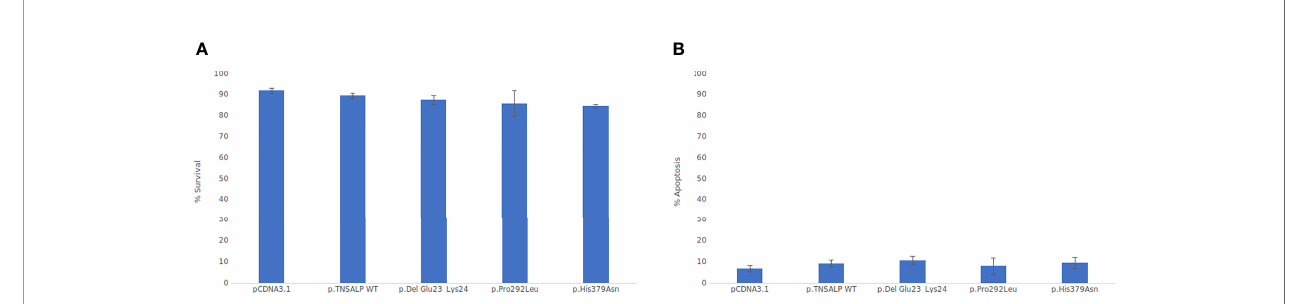
FIGURE 4 | Viability cell assay graphs. ANOVA corrected by Tukey ’ s test was used for comparisons between groups Statistically signi fi cant differences was set at a p- value <0.05. (A) Percentage of cell viability. (B) Percentage of apoptotic